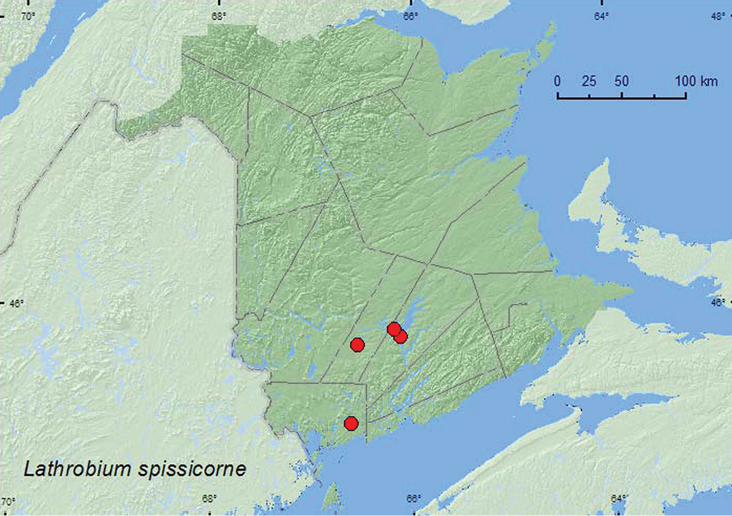
Collection localities in New Brunswick, Canada of Lathrobium spissicorne.